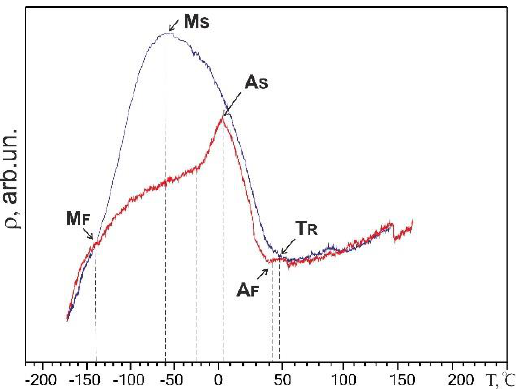
Figure 4. Temperature dependences of electrical resistivity  (T) for a 60 µm diameter TiNi